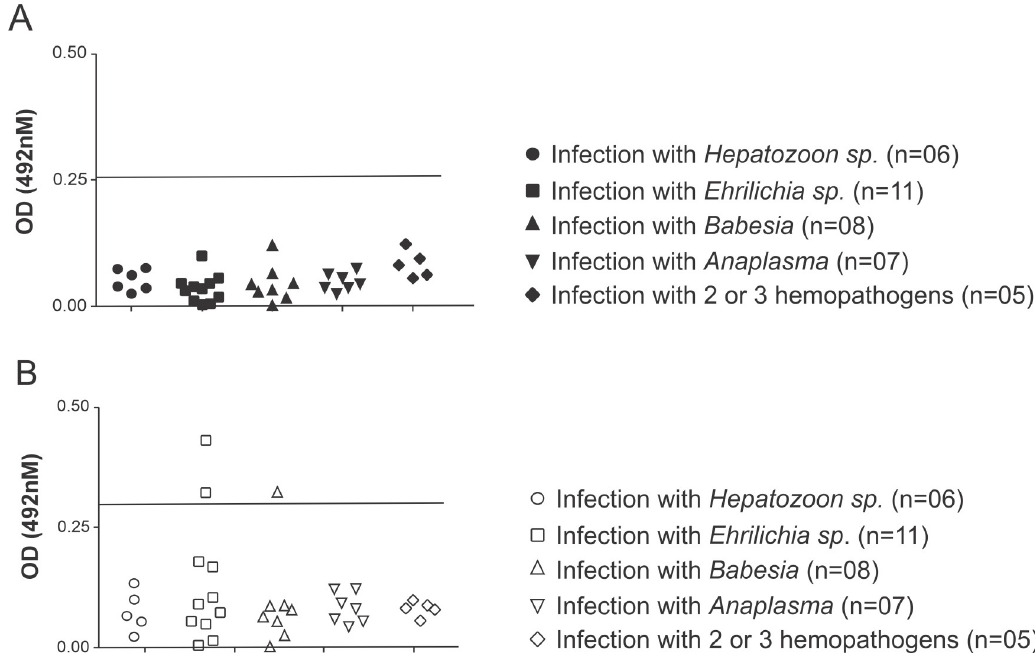
Fig 5. Evaluation of the occurrence of cross-reactivity with the (A) LPG and (B) TLA-ELISAs with samples from dogs infected with other protozoa and bacteria of small animal medicine importance. Serum samples from dogs infected with Hepatozoon sp., Ehrlichia sp., Anaplasma sp. and Babesia sp. were tested individually using the LPG-ELISA or TLA-ELISA.